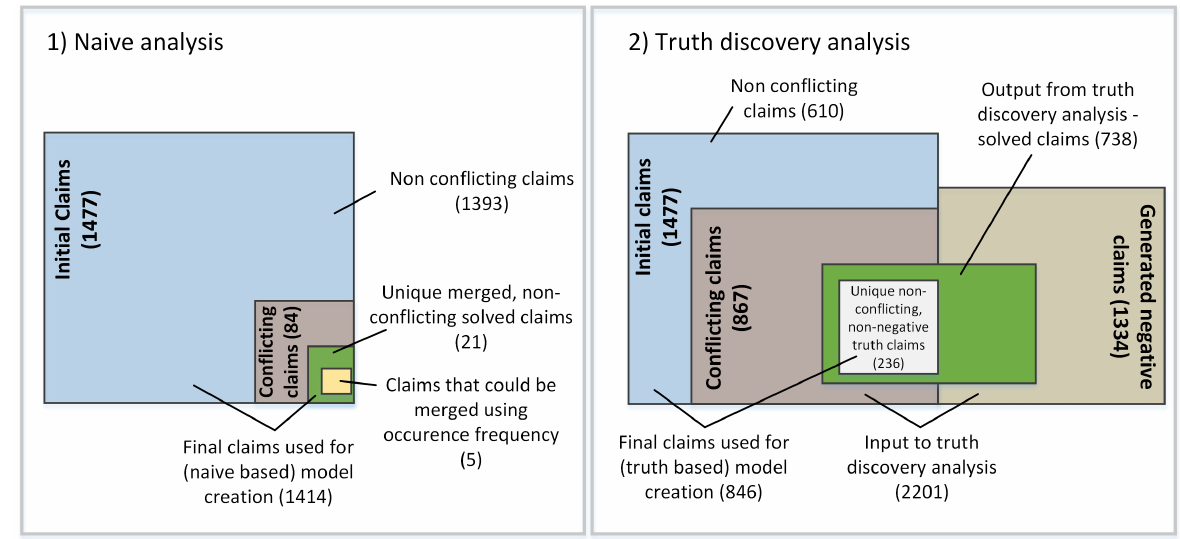
Figure 9. Venn diagrams of securiCAD claims in naive and truth discovery analysis